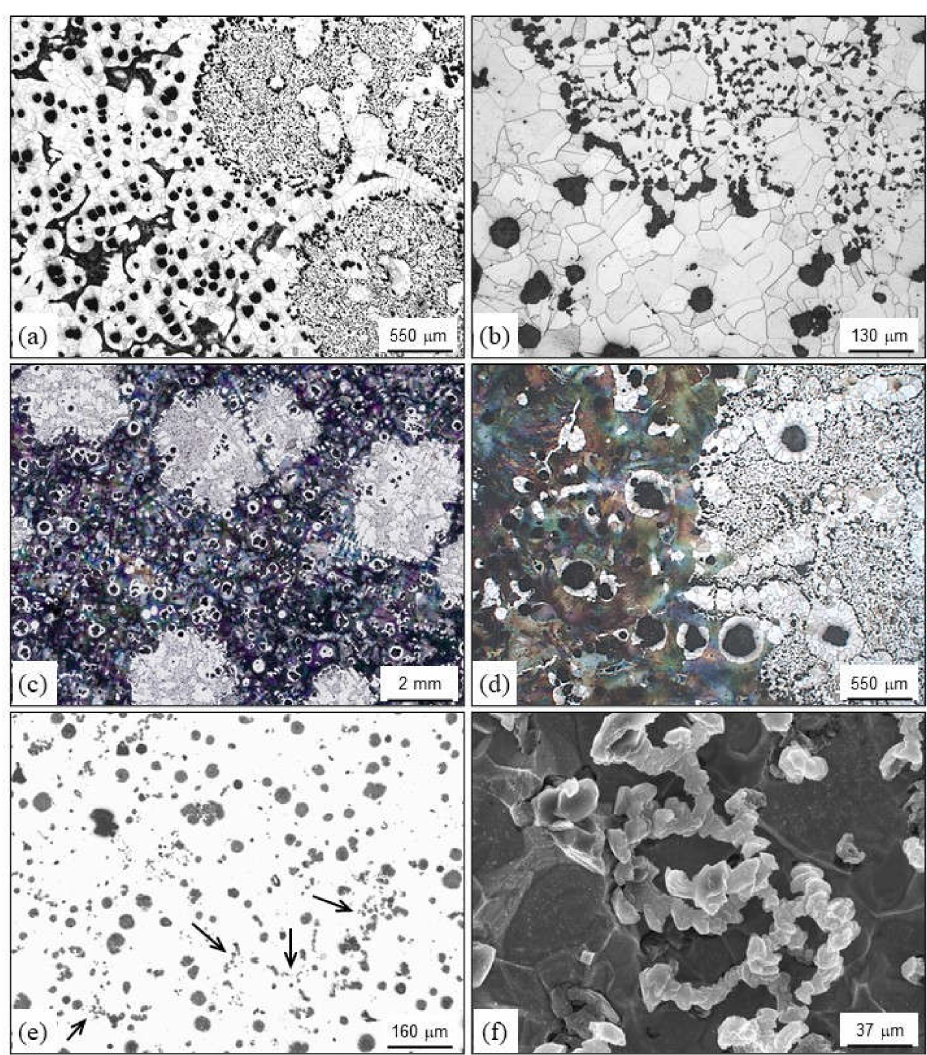
Figure 83. Conventional chunky graphite distribution in ferritic ductile iron castings ( a , b ). Chunky graphite cells in pearlitic ductile iron castings ( c , d ). Appearance of this defect in a Y2-wedge manu- factured with a high silicon ductile iron alloy ( e ) and SEM view after deep etching this sample ( f